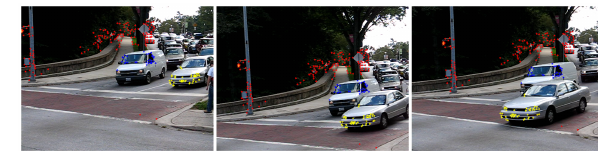
Figure 1: Example results of the motion segmentation on the real traffic video from the Hopkins 155 dataset (Tron and Vidal,